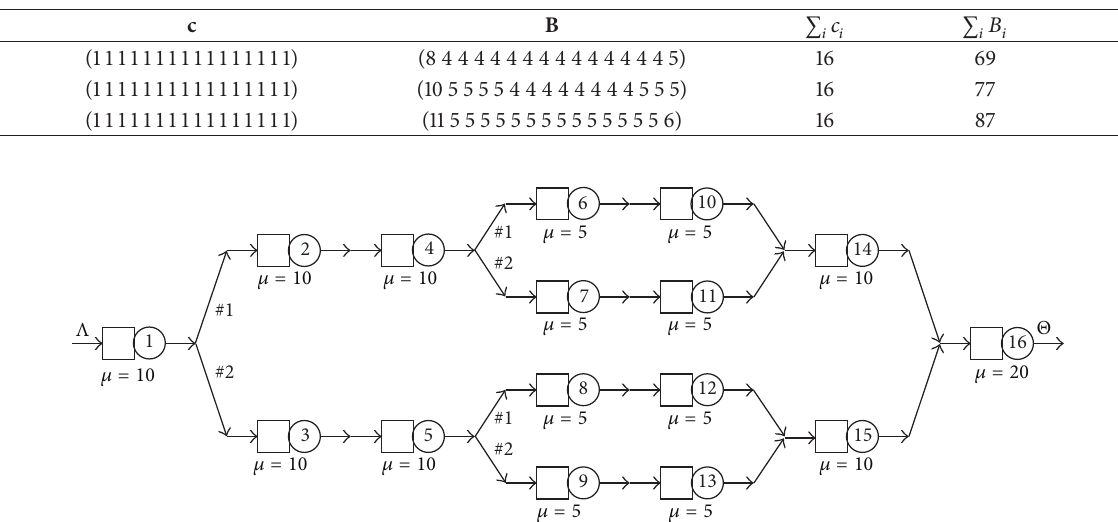
Figure 3: Combined